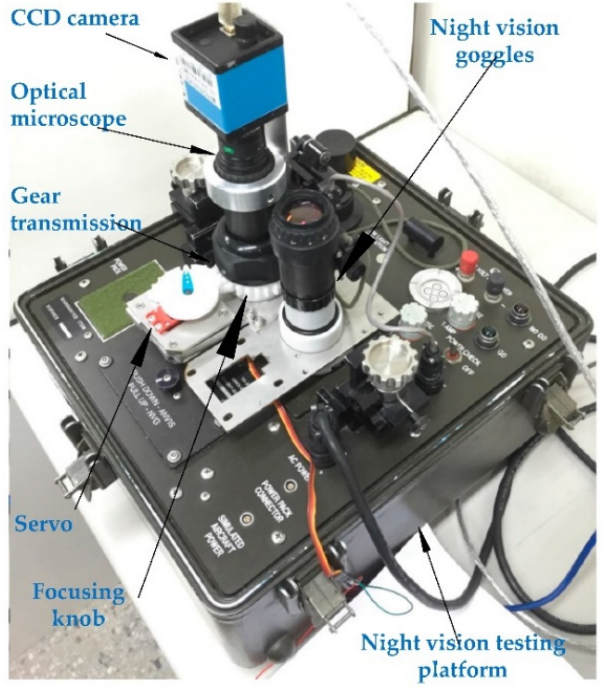
Figure 2. System installation [1].